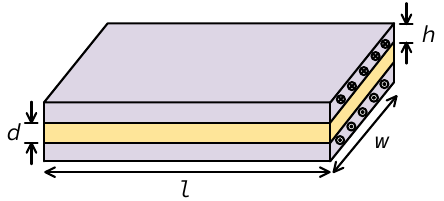
Figure 6. Laminated busbar structure model.